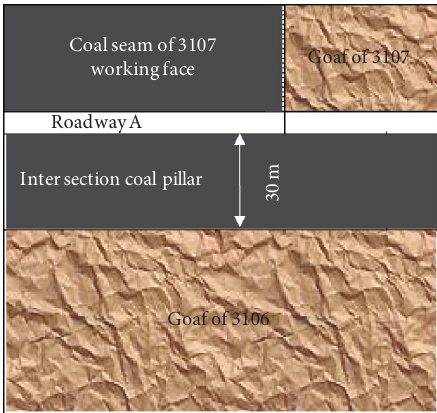
Figure 1: Layout of the working